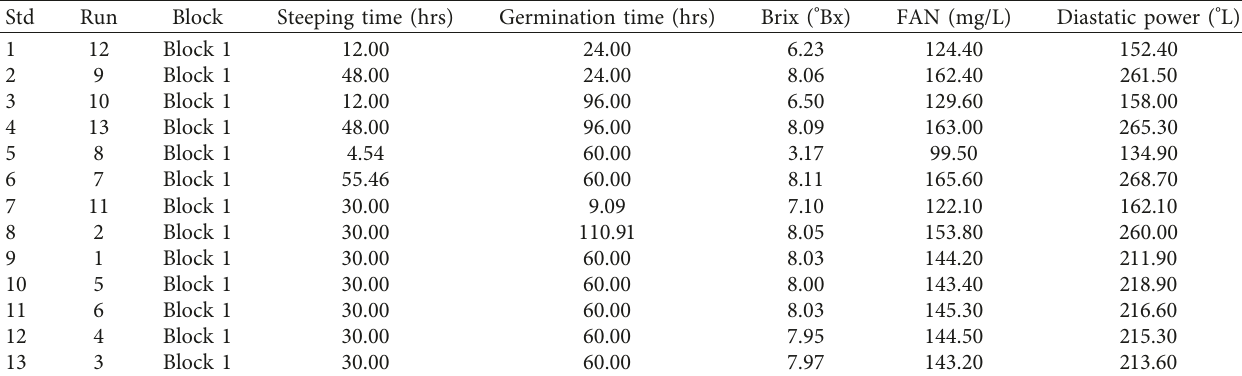
Table 5: A central composite design (CCD) for quinoa malting using response surface methodology.